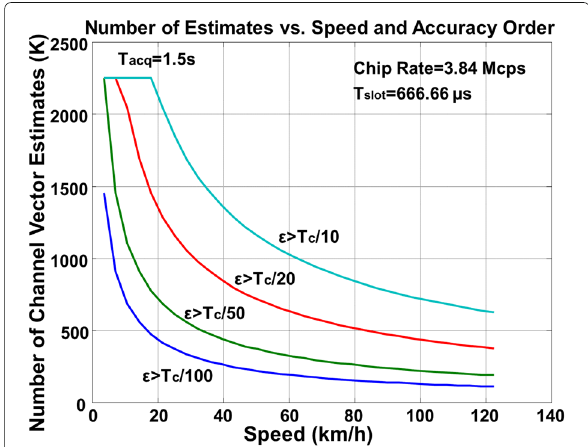
Fig. 1 Expected number of channel estimates available to achieve timing in terms of the subscriber speed. Results are exhibited for a maximum acquisition time of 1.5 s and several different allowed timing errors (cid:5) , given as fractions of chip